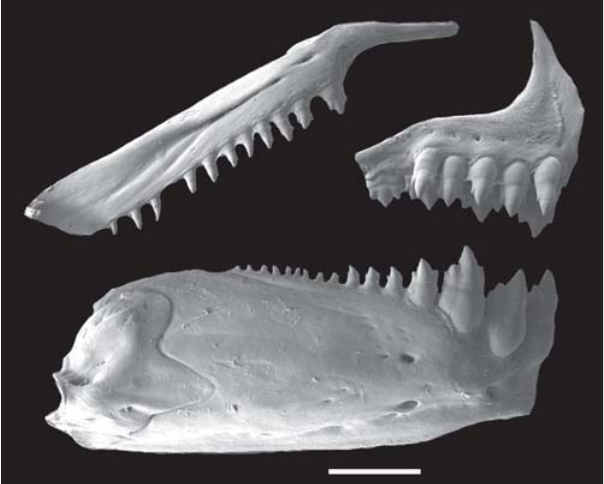
Fig. 22. Hemibrycon surinamensis , MHNG 227928, male, 58.9 mm SL. Scanning electron micrograph of right side upper and lower jaws. Scale bar = 1